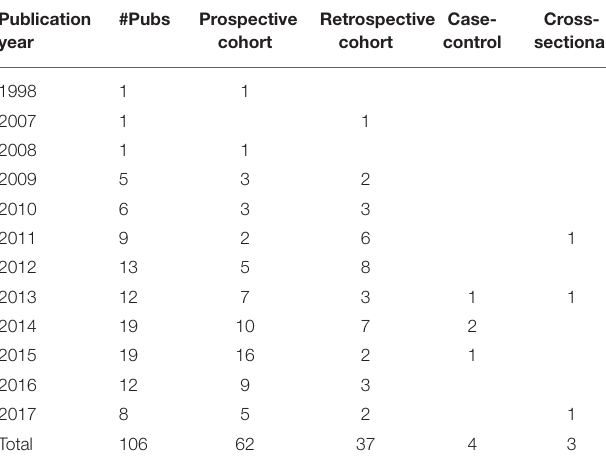
TABLE 5 | Number of included publications by year and study design.